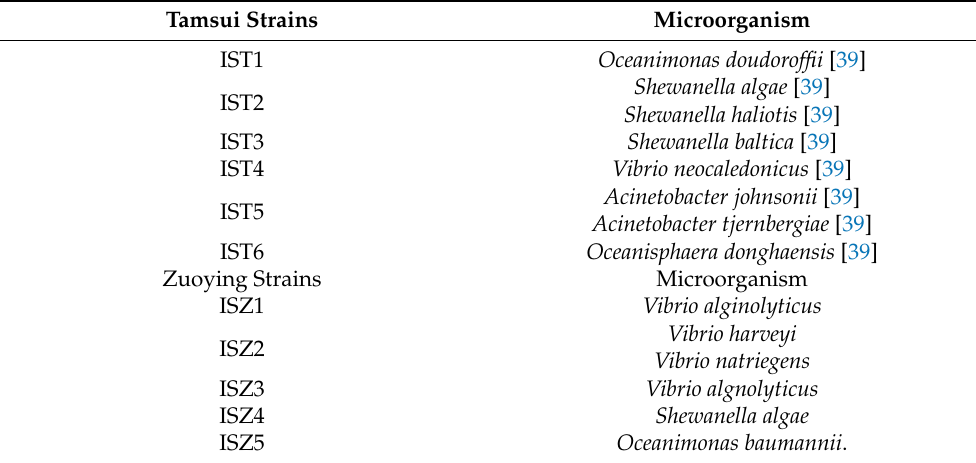
Table 1. Representative strains of Microorganisms from Tamsui and Zuoying harbors.